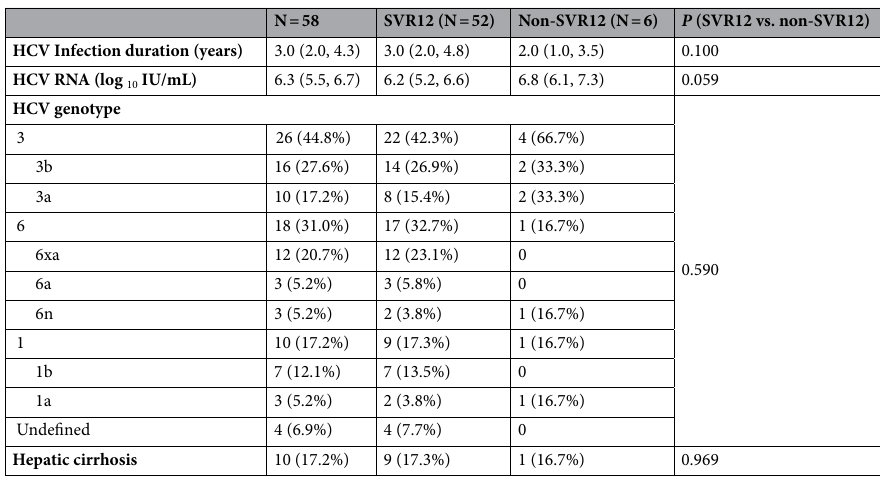
Table 2. Baseline HCV characterization of study subjects (Grouped by